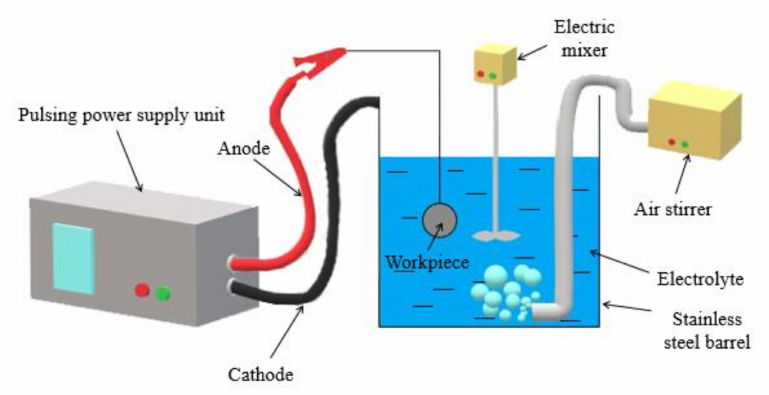
Figure 1. Schematic diagram of MAO process for TC4